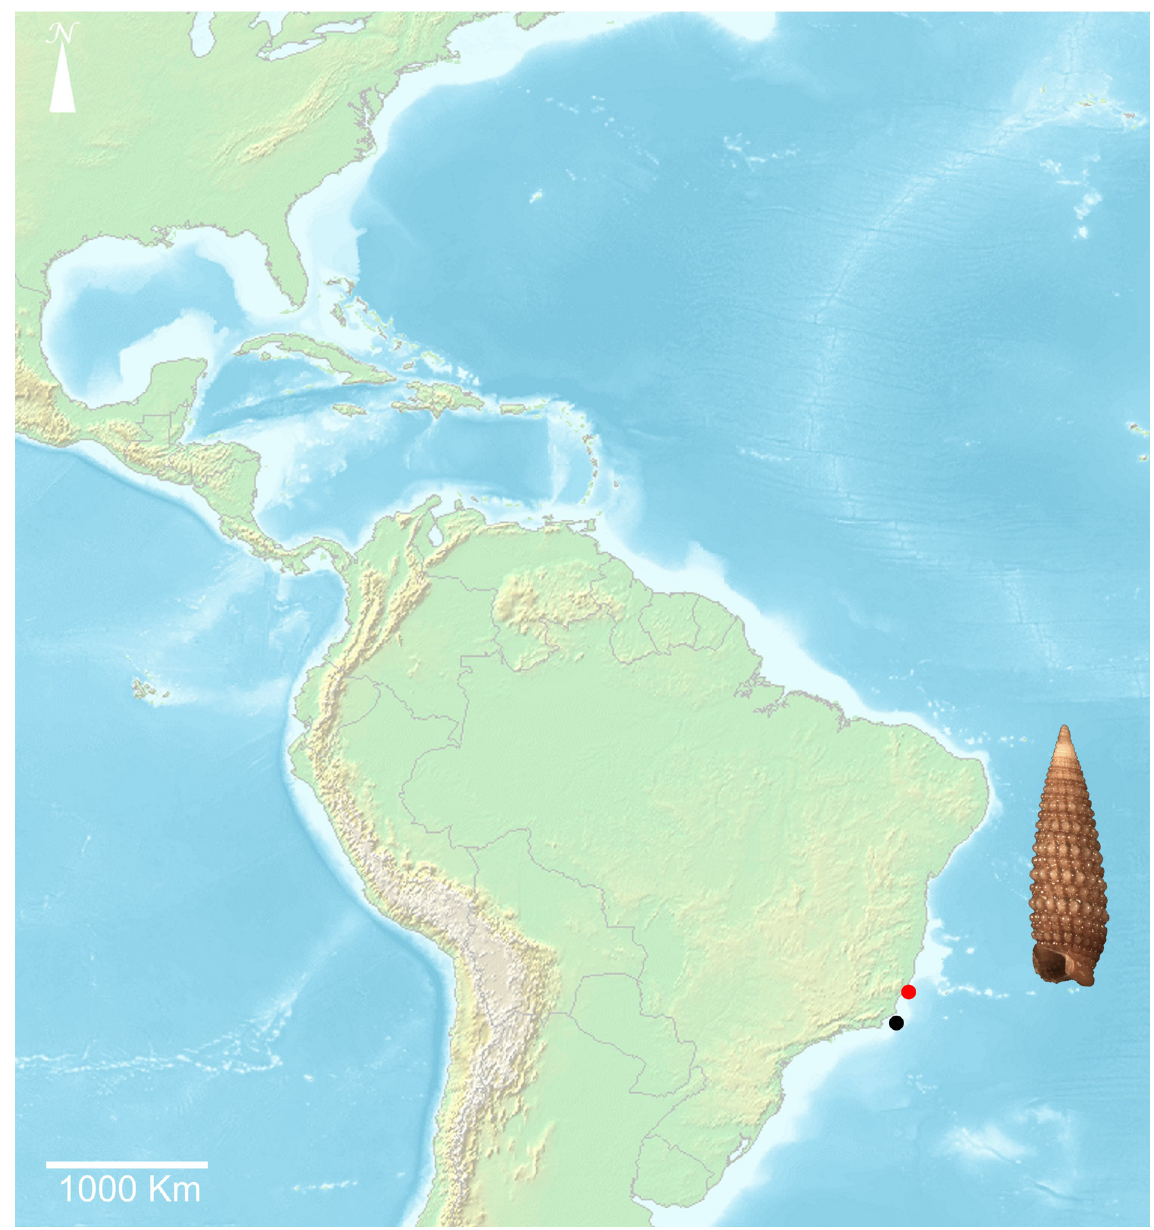
Fig. 58. Distribution map of Nanaphora leei Fernandes & Pimenta, 2015; red circle = type